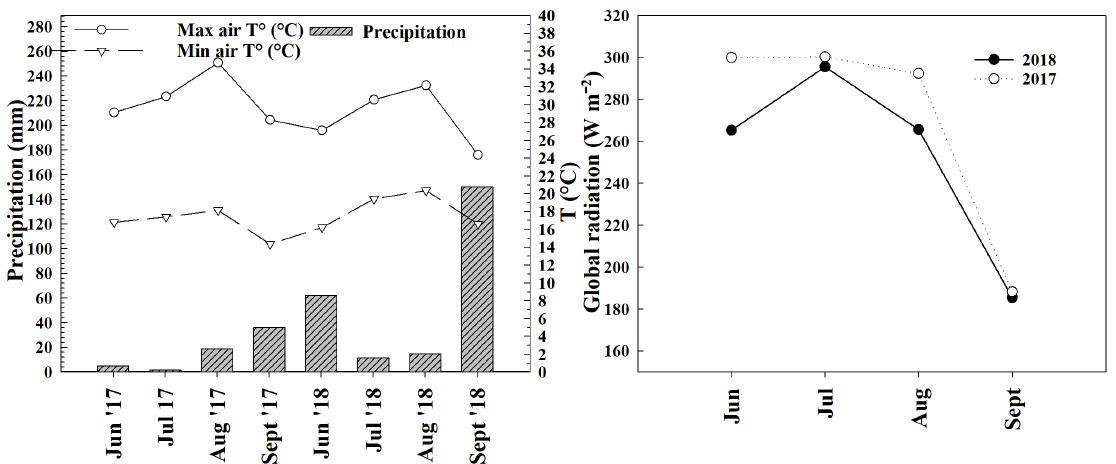
Figure 1. Climate parameters of the experimental location. Monthly averages of mean, maximum, and minimum air temperature ( ◦ C), summation monthly rainfall (mm), and global radiation (RAD, W m − 2 ) were measured from June to September (2017–2018).